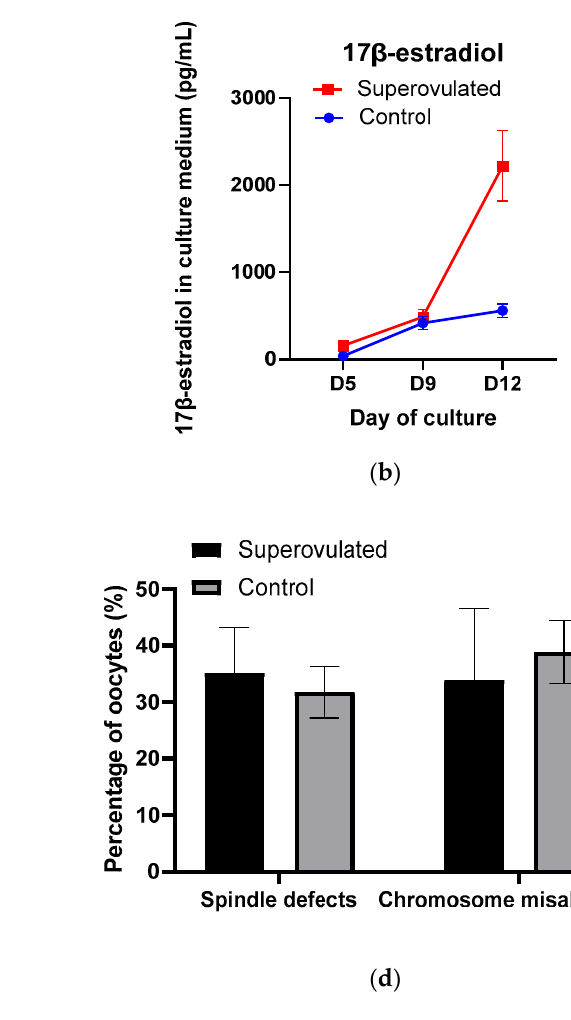
Table 2. Follicular sizes during culture (mean follicle diameter ± standard deviation, µm) of follicles from superovulated ovaries vs. controls (** p < 0.01, *** p < 0.001).